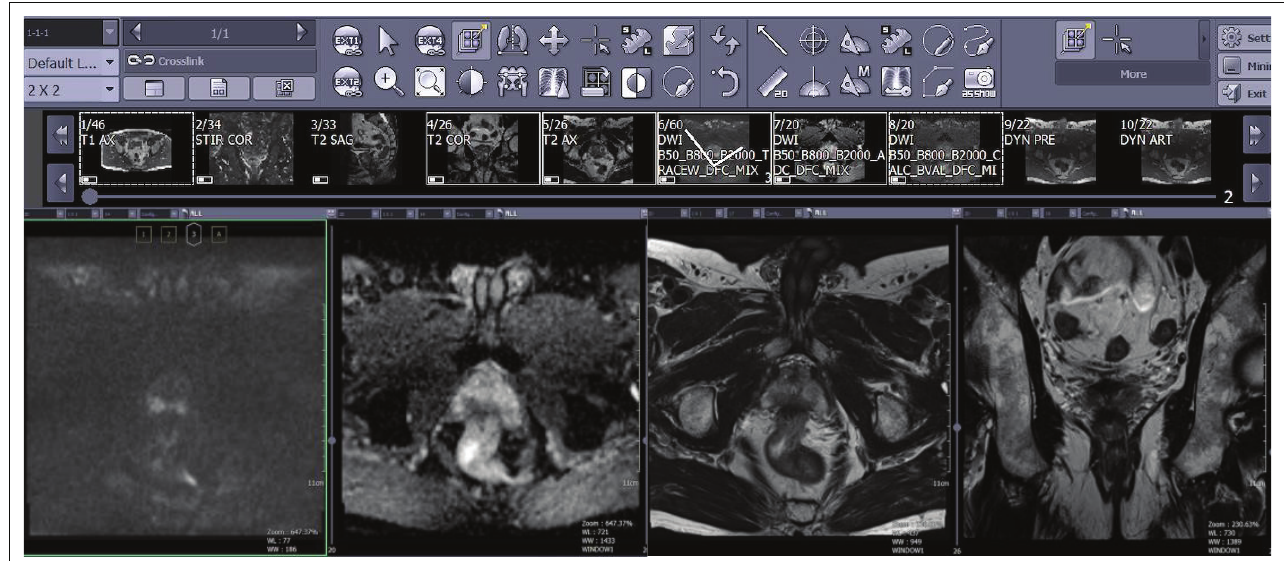
FIGURE 2: Workstation layout of four sequences used for multiparametric prostate magnetic resonance imaging evaluation of the prostate including (left to right) high b -value diffusion-weighted imaging, Apparent Diffusion Coefficient (ADC) map, axial and coronal T2-weighted imaging.